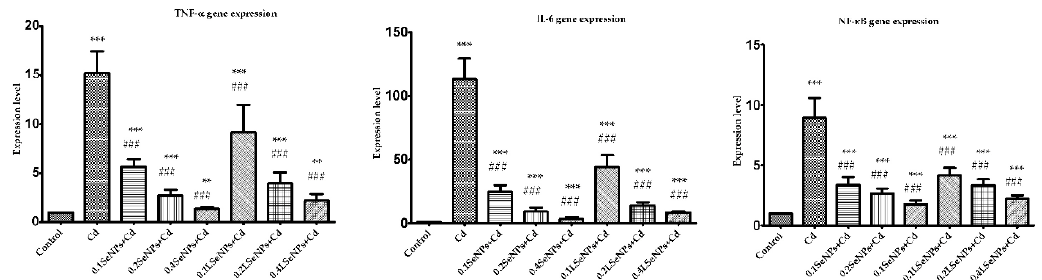
Figure 6. Renal TNF- α , IL-6, NF-kB gene expressions. Groups: Control-mice received only water; Cadmium group (Cd)-mice received orally 5 mg/kg CdCl 2 ; 0.1 SeNPs + Cd (0.1 mg/kg SeNPs + 5 mg/kg CdCl 2 ); 0.2 SeNPs + Cd (0.2 mg/kg SeNPs + 5 mg/kg CdCl 2 ); 0.4 SeNPs + Cd (0.4 mg/kg SeNPs + 5 mg/kg CdCl 2 ); 0.1 LSeNPs + Cd (0.1 mg/kg LSeNPs + 5 mg/kg CdCl 2 ); 0.2 LSeNPs + Cd (0.2 mg/kg LSeNPs + 5 mg/kg CdCl 2 ); 0.4 LSeNPs + Cd (0.4 mg/kg LSeNPs + 5 mg/kg CdCl 2 ). Groups: SeNPs + Cd and LSeNPs + Cd at different concentration vs. control group: ** p < 0.01; *** p < 0.001. Groups: SeNPs + Cd and LSeNPs + Cd at different concentration vs. cadmium group (Cd): ### p < 0.001.